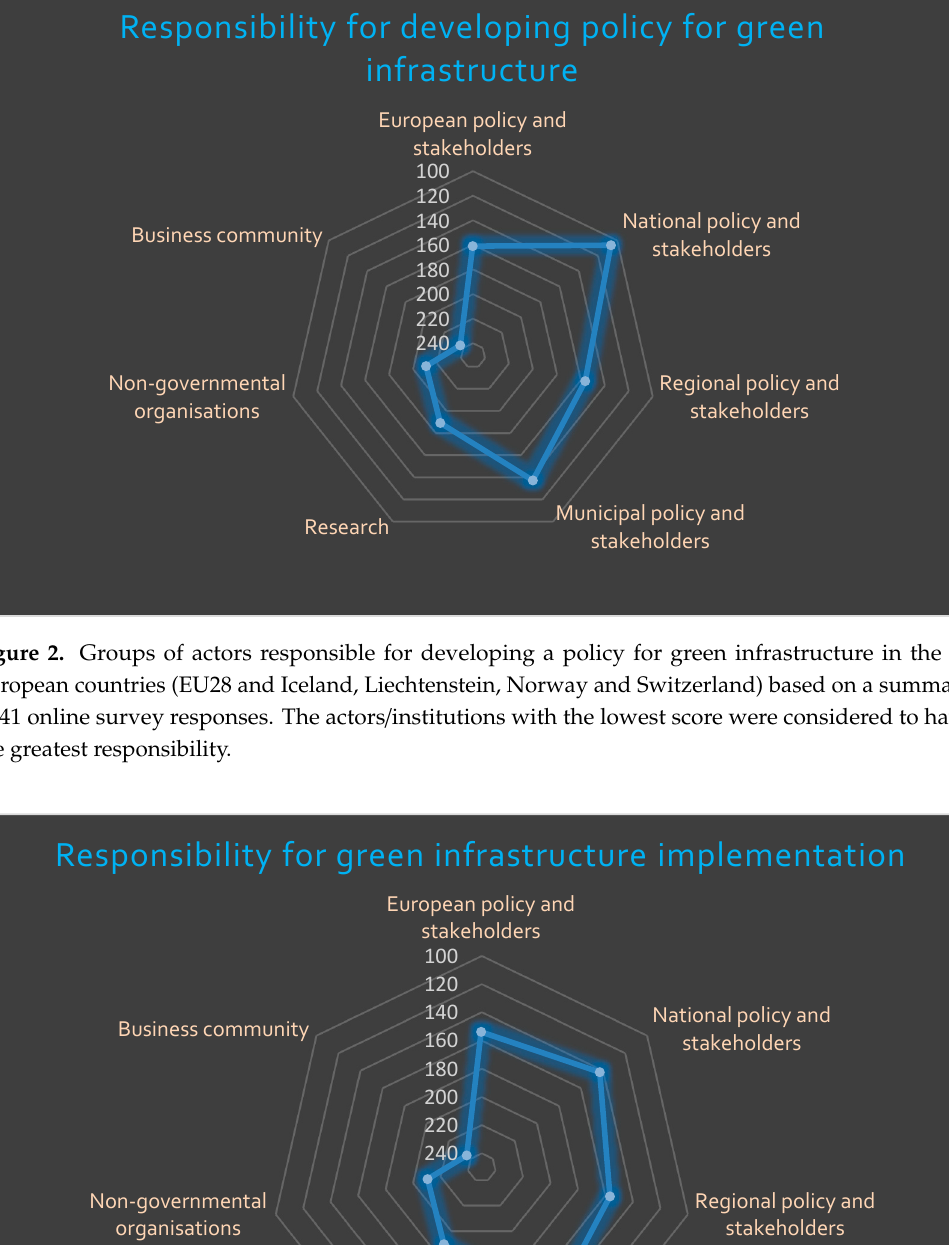
Figure 3. Groups of actors responsible for implementing green infrastructure in the 32 European countries (EU28 and Iceland, Liechtenstein, Norway and Switzerland) based on a summary of 41 online survey responses. The actors / institutions with the lowest score were considered to have the greatest